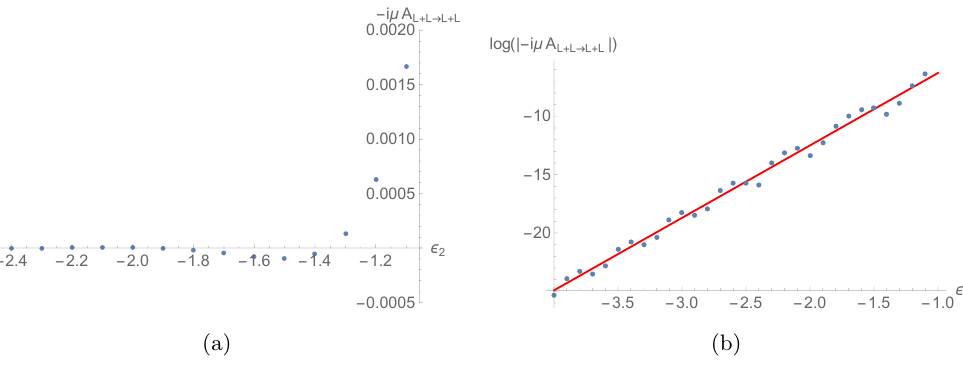
Figure 11 . Long string amplitude A L + L ! L + L as a function of incoming long string renormalized energy (cid:15) 2 , evaluated at a (cid:12)xed outgoing long string renormalized energies (cid:15) 1 = 3 : 0 and (cid:15) 3 = 0 : 5. In (b) we plot the logarithm of the absolute value of the amplitude over a range of su(cid:14)ciently large negative (cid:15) 2 . The red line represents a linear (cid:12)t of slope 6 : 21, which is in reasonable agreement withour expectation that the amplitude is modulated by a e 2 (cid:25) min( (cid:15) i ) pro(cid:12)le in this